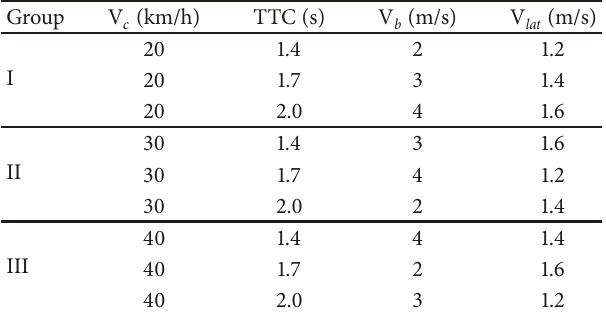
Table 3: Orthogonal experimental setup of